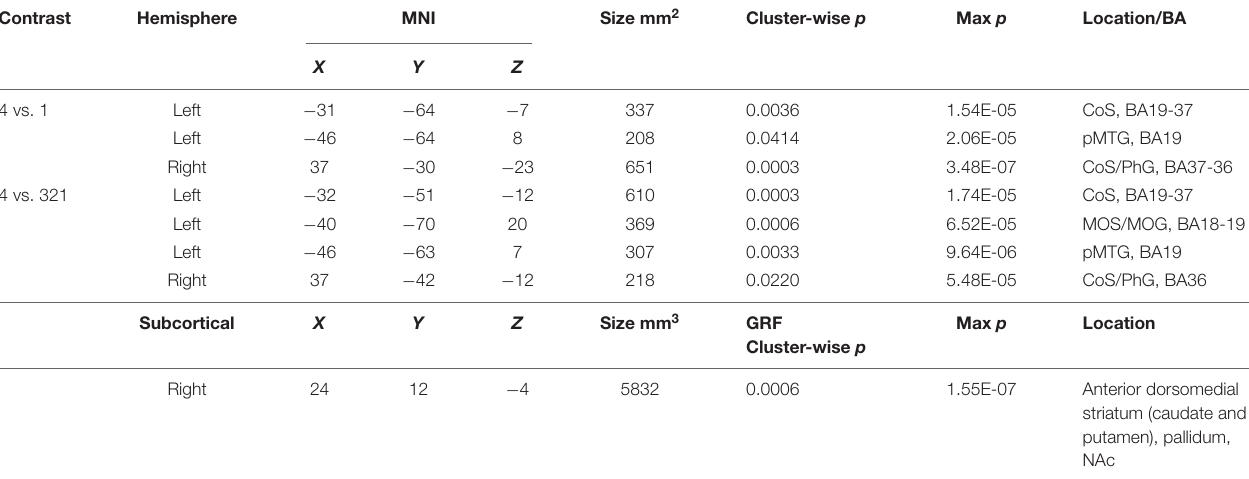
TABLE 1 | MNI coordinates for activations found in a whole-brain beta series GLM analysis for 4 vs. 1 and 4 vs. 321 contrasts.